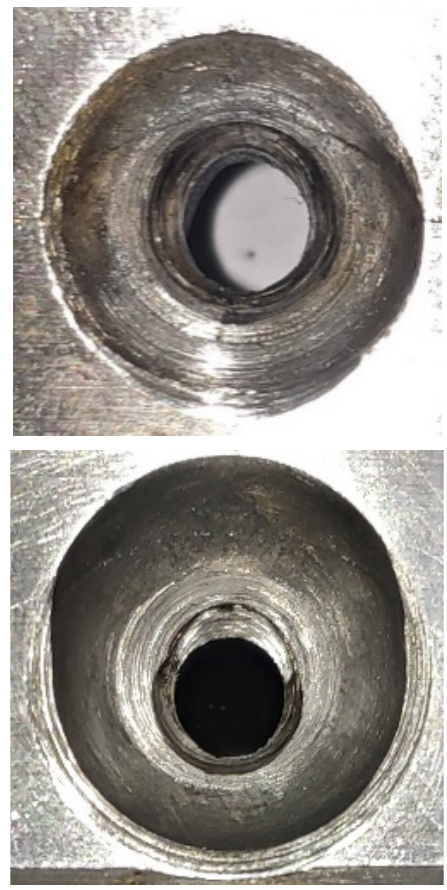
Figure 16. Non-compliance of ICZs for the BFP due to abrasion and